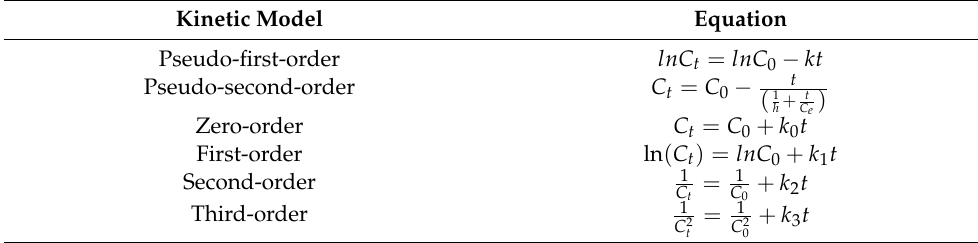
Table 1. Kinetic models. Kinetic Model